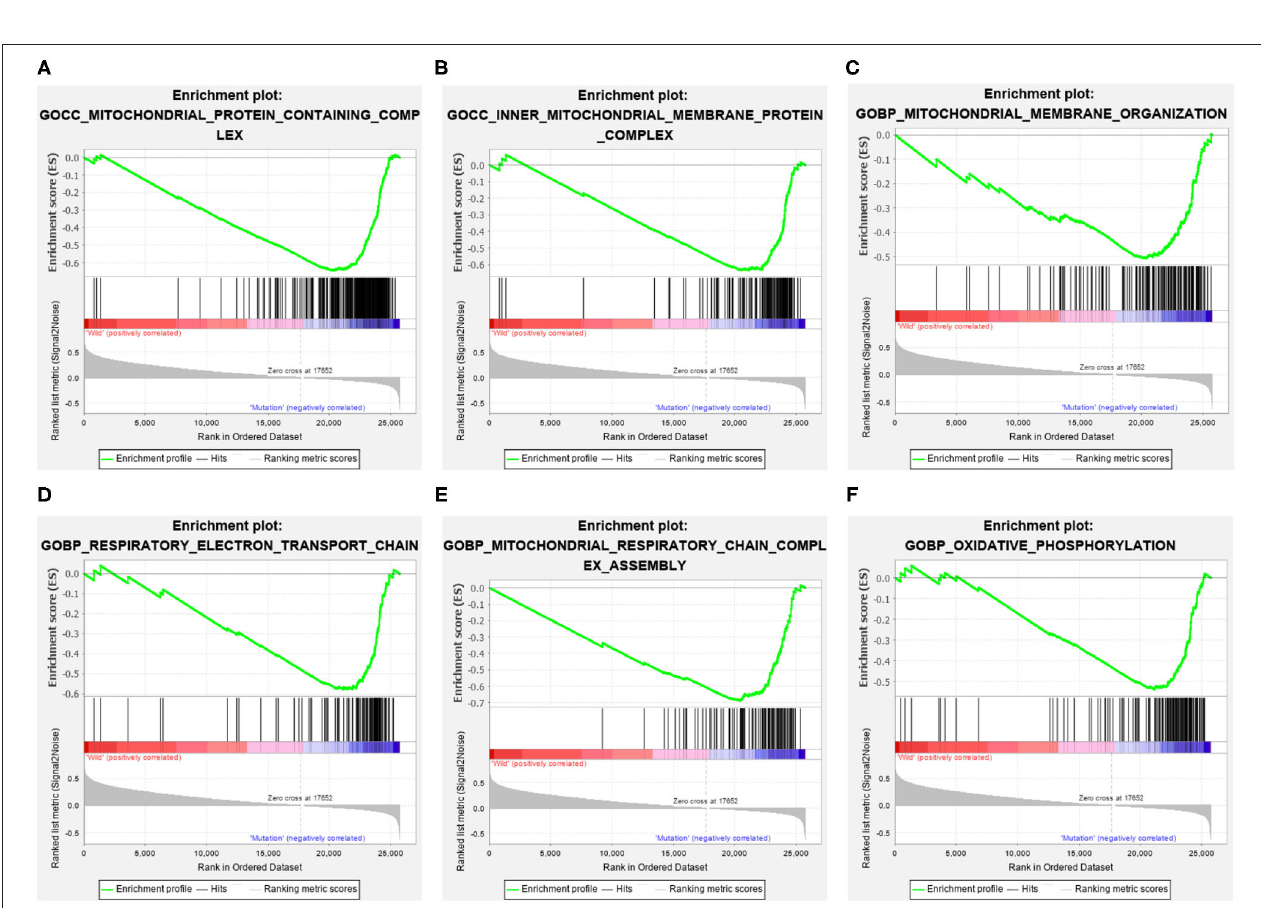
FIGURE 6 | The significantly enriched GO terms in mutated PLIN5 GC samples based on GSEA. (A) Mitochondrial protein containing complex, (B) inner mitochondrial membrane protein complex, (C) mitochondrial membrane organization, (D) respiratory electron transport chain, (E) mitochondrial respiratory chain complex assembly, and (F) oxidative phosphorylation. GO, Gene Ontology; GC, gastric cancer; GSEA, Gene Set Enrichment Analysis.